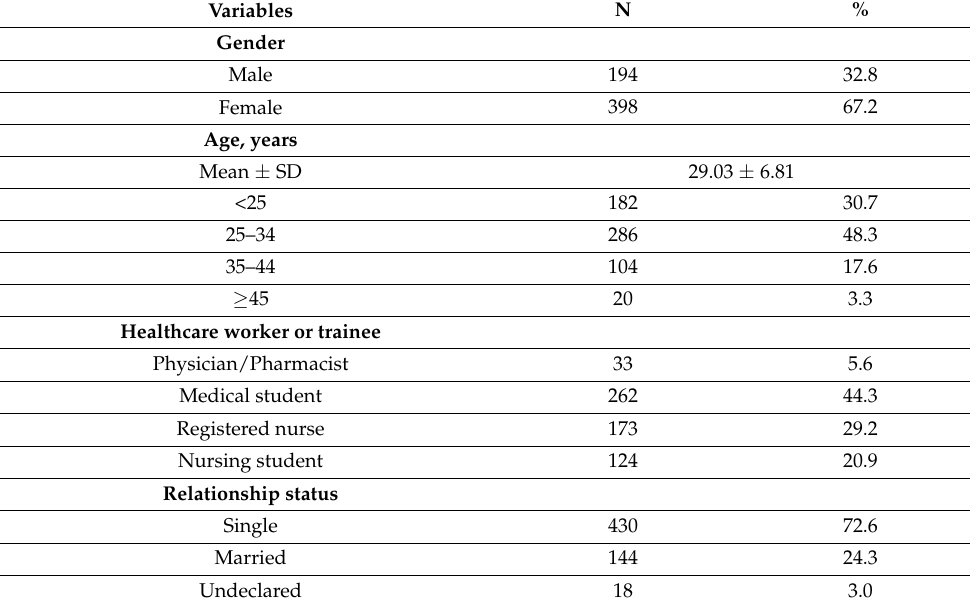
Table 1. Sociodemographic and health characteristics of participants (N =